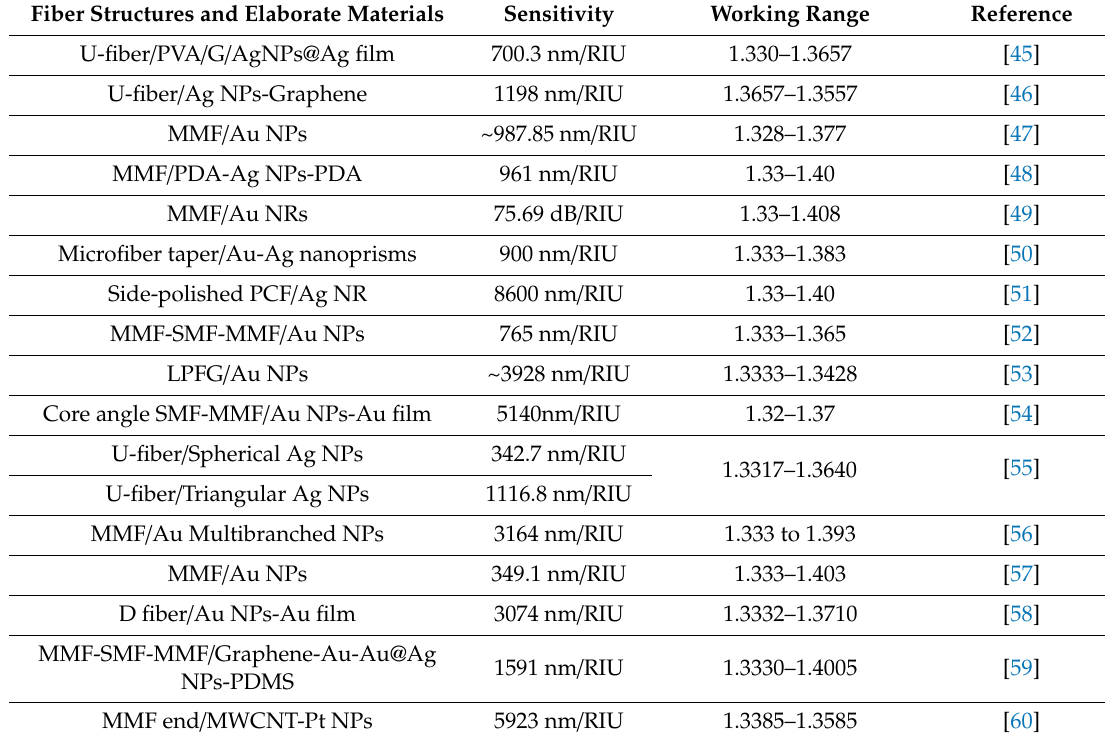
Table 1. Refractive index sensing performance comparison of fiber-LSPR sensors.